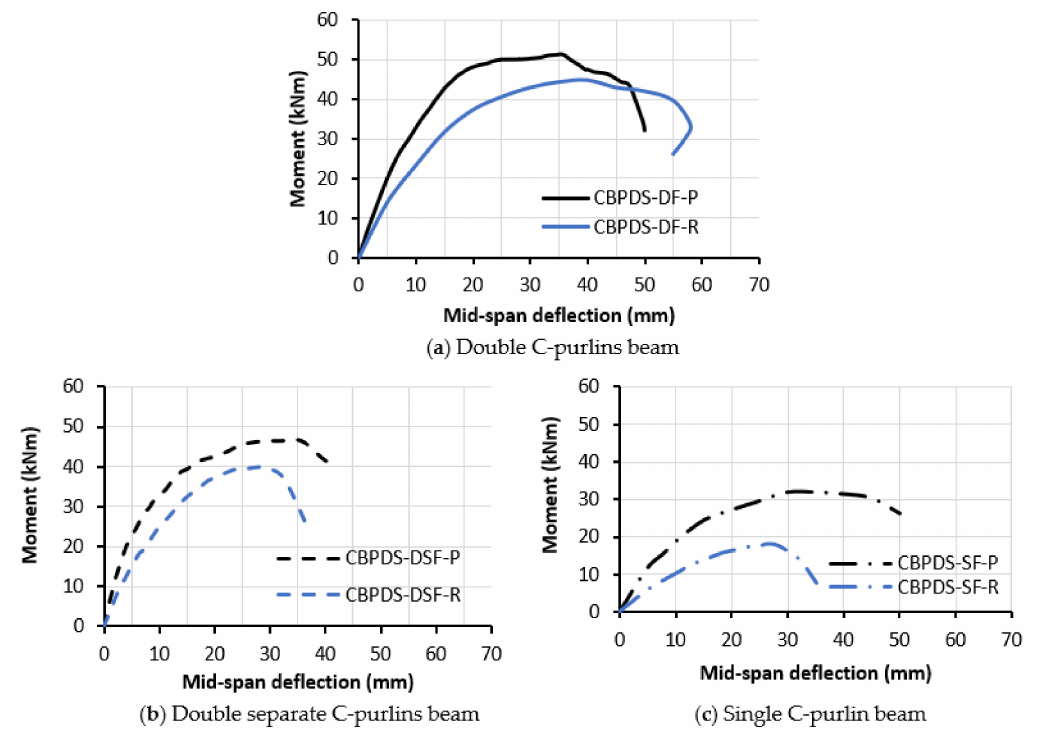
Figure 16. Effects of PSS direction (parallel and